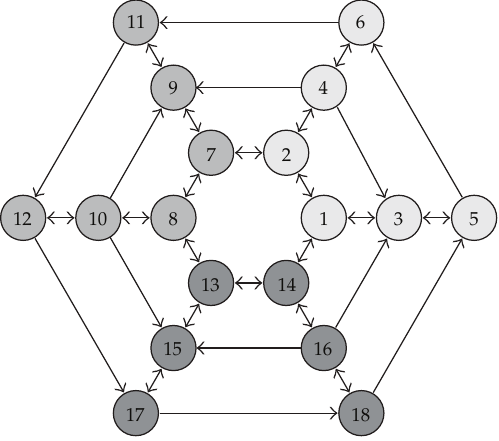
Figure 2: A community network with size N (cid:8) 18. There are three communities, each of them is denoted by the dots with gray degree.